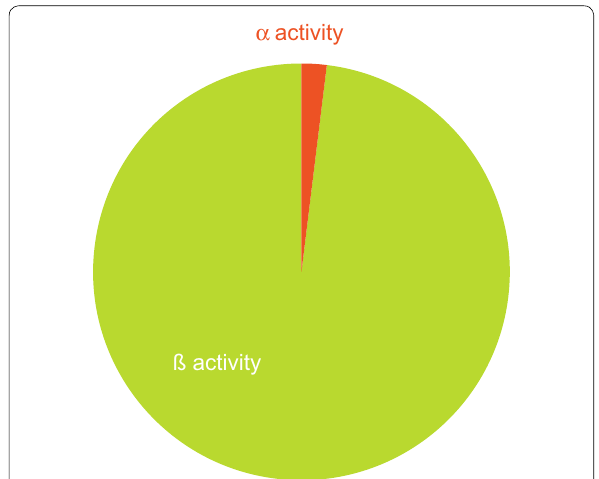
Fig. 2 Pie-chart comparing mean α and β activities from